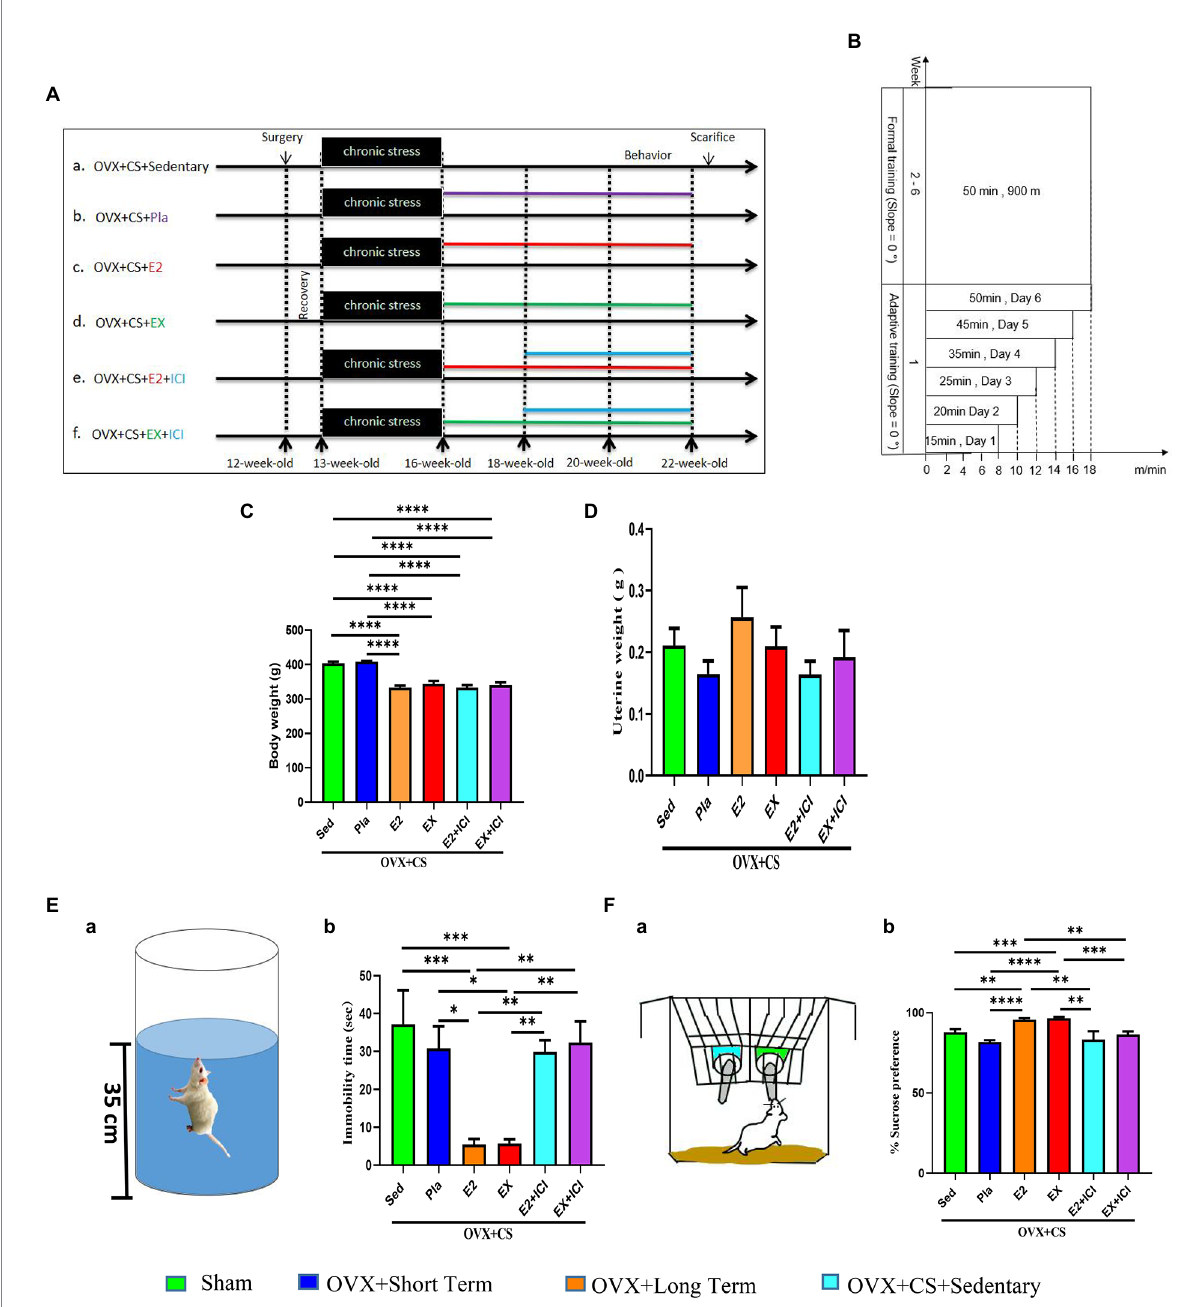
FIGURE 3 Estrogen and aerobic exercise effectively improved the depressive-like phenotype in depressed rats, but estrogen receptor antagonists reversed the antidepressant effect of aerobic exercise. (A) Experimental design. After the end of depression modeling, estrogen was administered (0.5 mM, 40 ug/Kg BW/day, ip) for a total of 6 weeks and antagonist was administered (10 μ M, 10 mg/Kg BW/day, ip) for a total of 4 weeks. (B) Exercise program. The first week is the acclimatization training, the first day of training is 8 m/min, 0 ° , 15 min, after that the running speed is increased by 2 m/min per day, the exercise time is 5–10 min per day progressive increments, exercise acclimatization on the sixth day to 18 m/min, 0 ° , 50 min. Rest day on Sunday. The second week to the sixth week is the official training period, running platform program finally set at 18 m/min, 0 ° , 50 min. Body weight (C) and uterine weight (D) of rats in each group. (E) Schematic diagram of the sugar-water preference test (a) and percentage of sugar-water preference for statistical analysis (b) . (F) Schematic diagram of the forced swimming test (a) and immobility time (b) . All data are expressed as mean ± SEM ( n = 8–12). * P < 0.05, ** P < 0.05, *** P < 0.001, **** P <